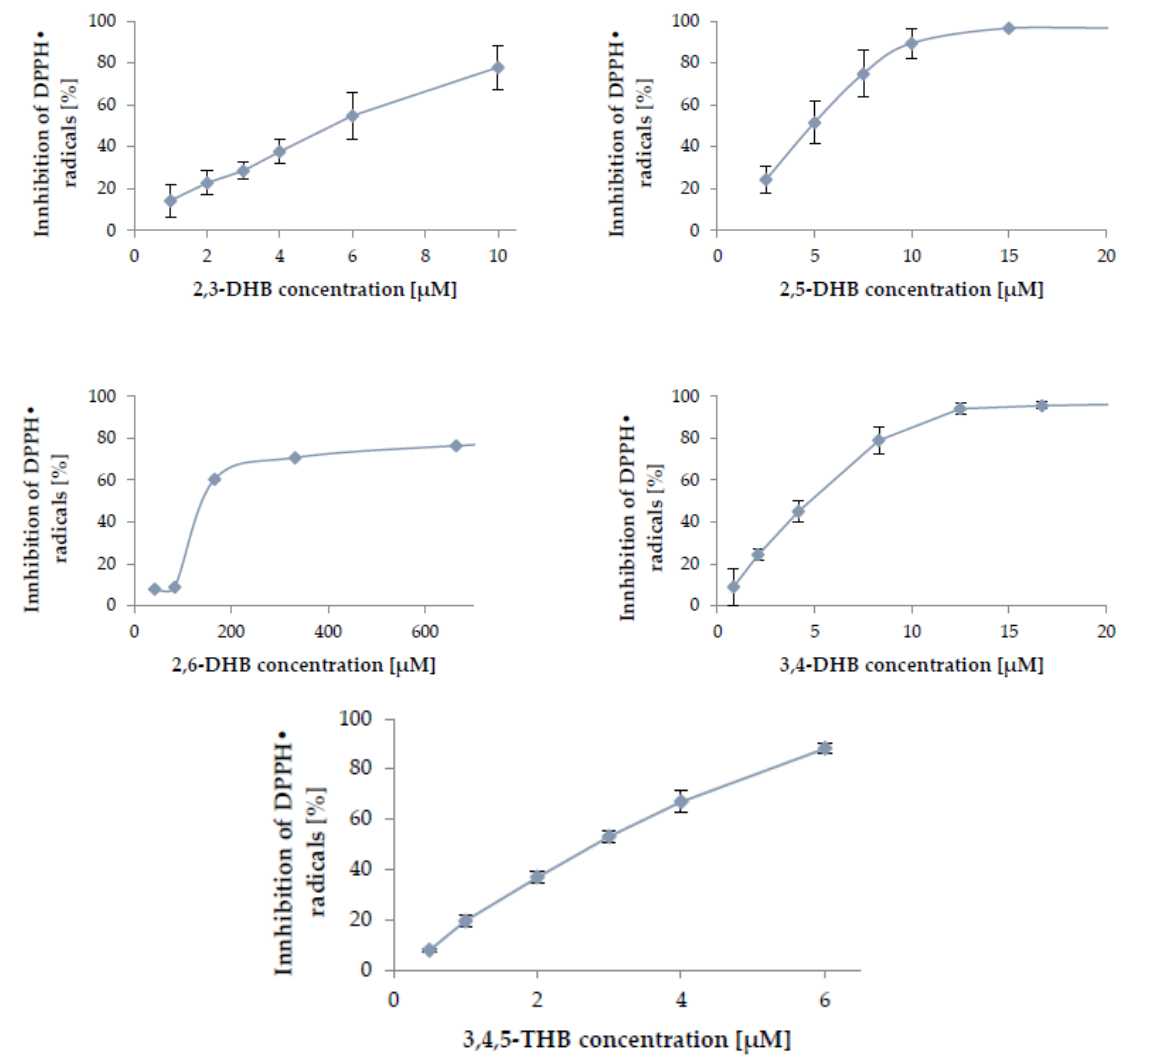
Figure 2. Scavenging of DPPH • radicals by 2,3-DHB, 2,5-DHB, 2,6-DHB, 3,4-DHB, and 3,4,5-THB. Mean values from three independent experiments ± SD are shown.